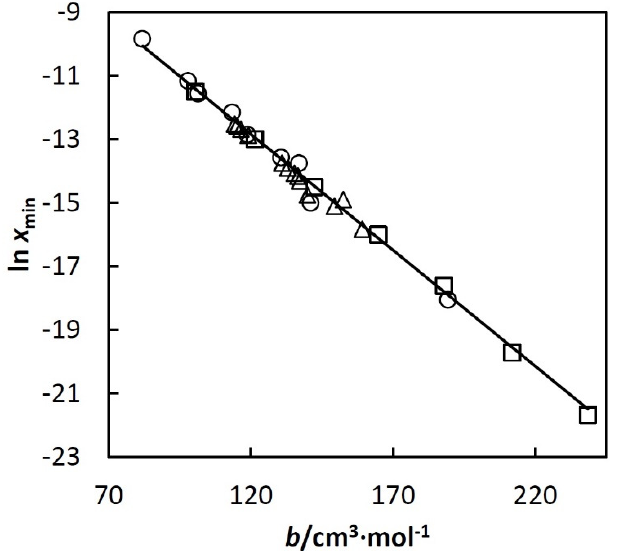
Figure 3. ln x min used in Equation (3) vs. excluded volume of the corresponding alkane, b ( b h ). Where symbols represent: □ , n- alkanes; ○ , cycloalkanes; ∆ , isoalkanes. The alkanes are listed below in in- creasing order of b within each group: cyclopentane, cyclohexane, methylcyclopentane, cyclohep- tane, methylcyclohexane, cyclooctane, ethylcyclohexane, propylcyclopentane, pentylcyclopentane, pentane, hexane, heptane, octane, nonane, decane, undecane, 2,2- and 2,3-dimethylbutane, 3-methylpentane, 2-methylpentane, 3,3-, 2,3-, 2,2- and 2,4-dimethylpentane, 3-methylhexane, 2-methylhexane, 2,3,4-trimethylpentane, 2,2,4-trimethylpentane and 3-methylheptane.